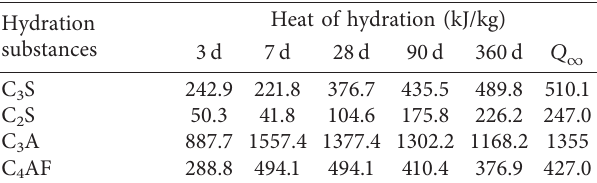
Table 4: Heat of hydration